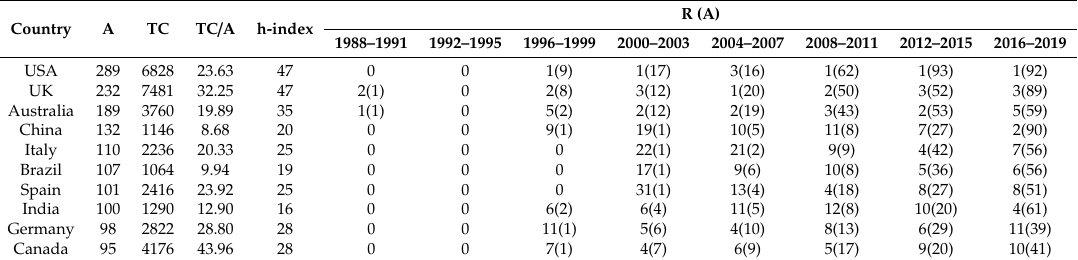
Table 6. Top 10 prolific countries in number of articles (1998–2019).